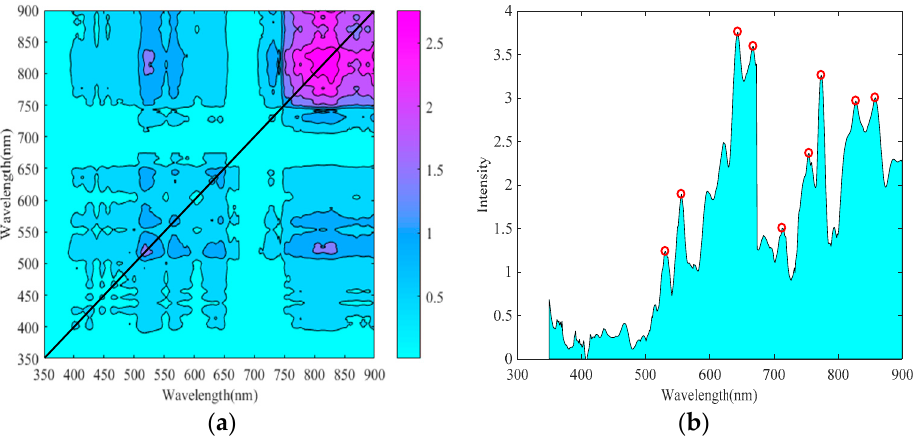
Figure 7. 2D correlation spectra of the winter wheat canopy for the grain-filling period: ( a ) Synchronous 2D spectra contour map; ( b ) diagonal of synchronous contour map.